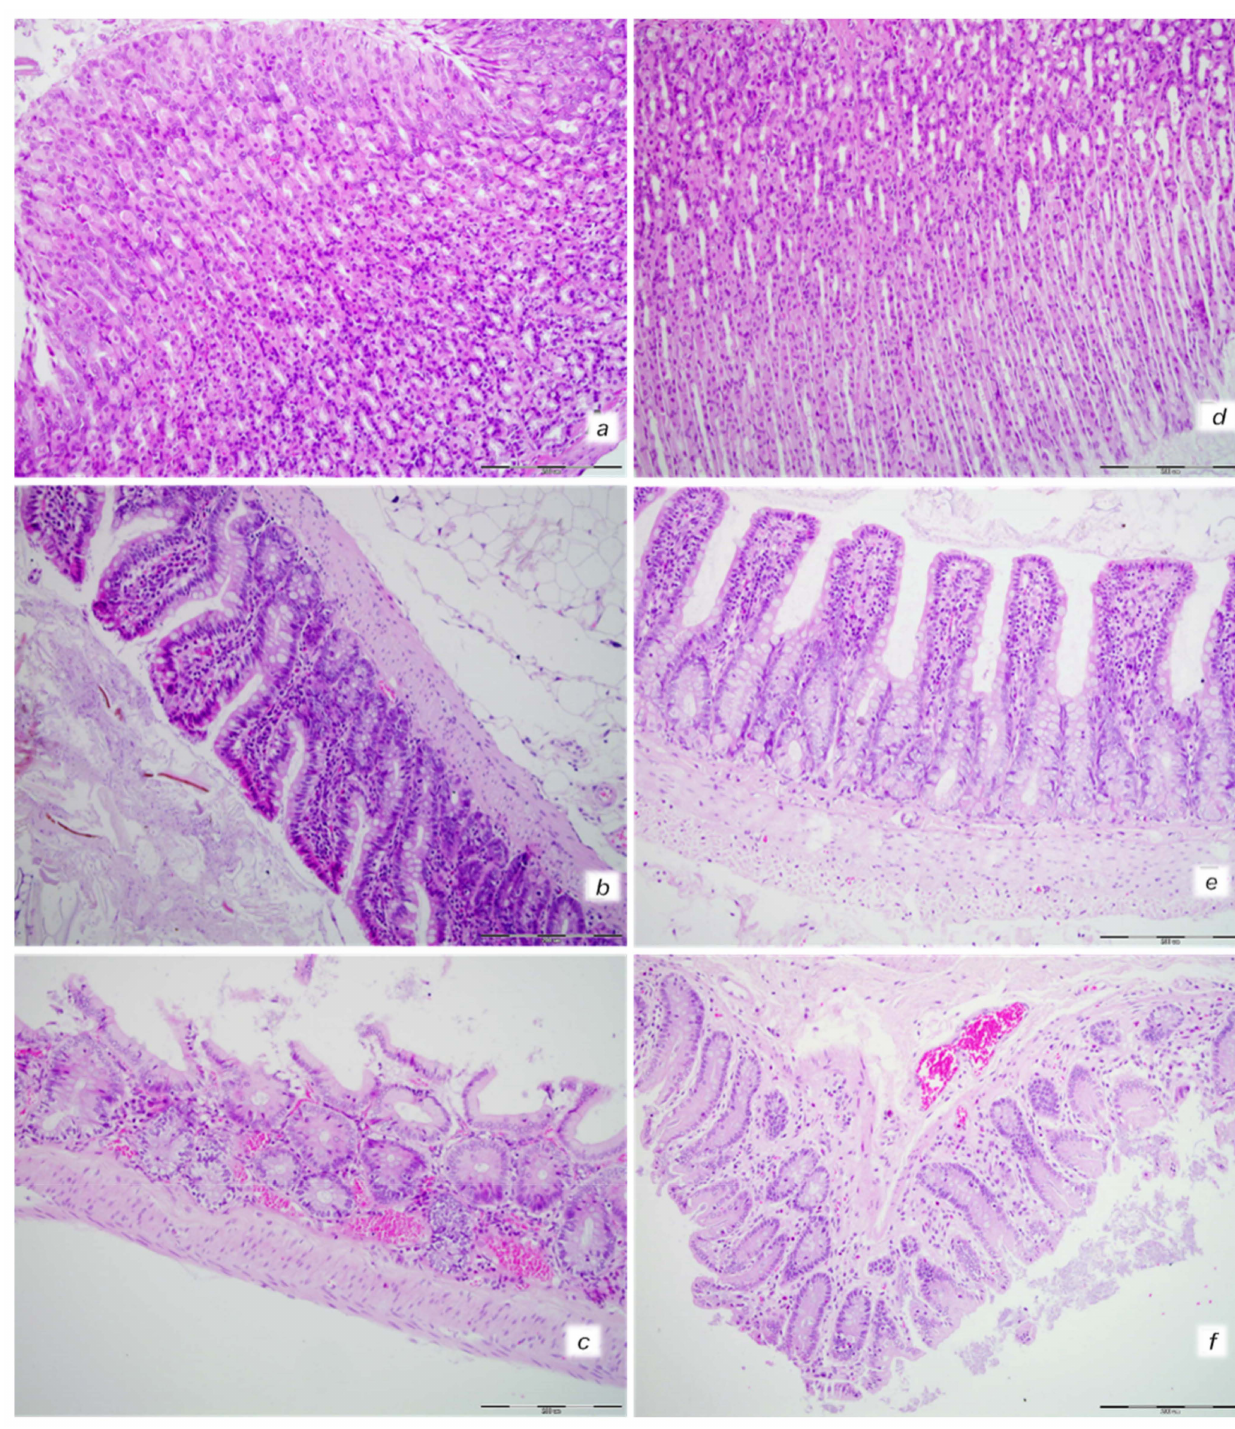
Figure 6. Gastrointestinal tract injury. Isoprenaline 75 mg/kg at 30 min after challenge. Control rats (( a ) (stomach), ( b ) (small intestine), ( c ) (large intestine)). Congestion in the upper and lower digestive tract with a tendency pronounced in the lower digestive tract. BPC 157-treated rats (( d ) (stomach), ( e ) (small intestine), ( f ) (large intestine)). No changes in the stomach and small intestine with mild congestion of the colon. (HE staining; magnification 200 × ; scale bar 200 µ